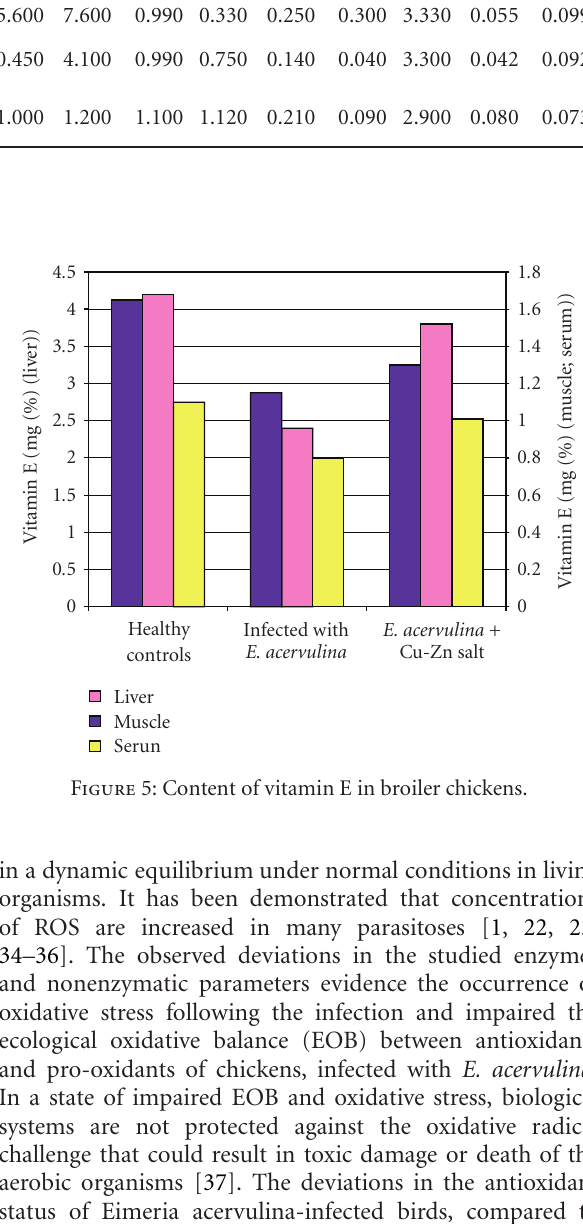
Table 1: SD, %, values for the parameters MDA, SOD, CAT, Cu, Zn, and Vitamins E and C. Groups Healthy controls 0.07 Infected with E.